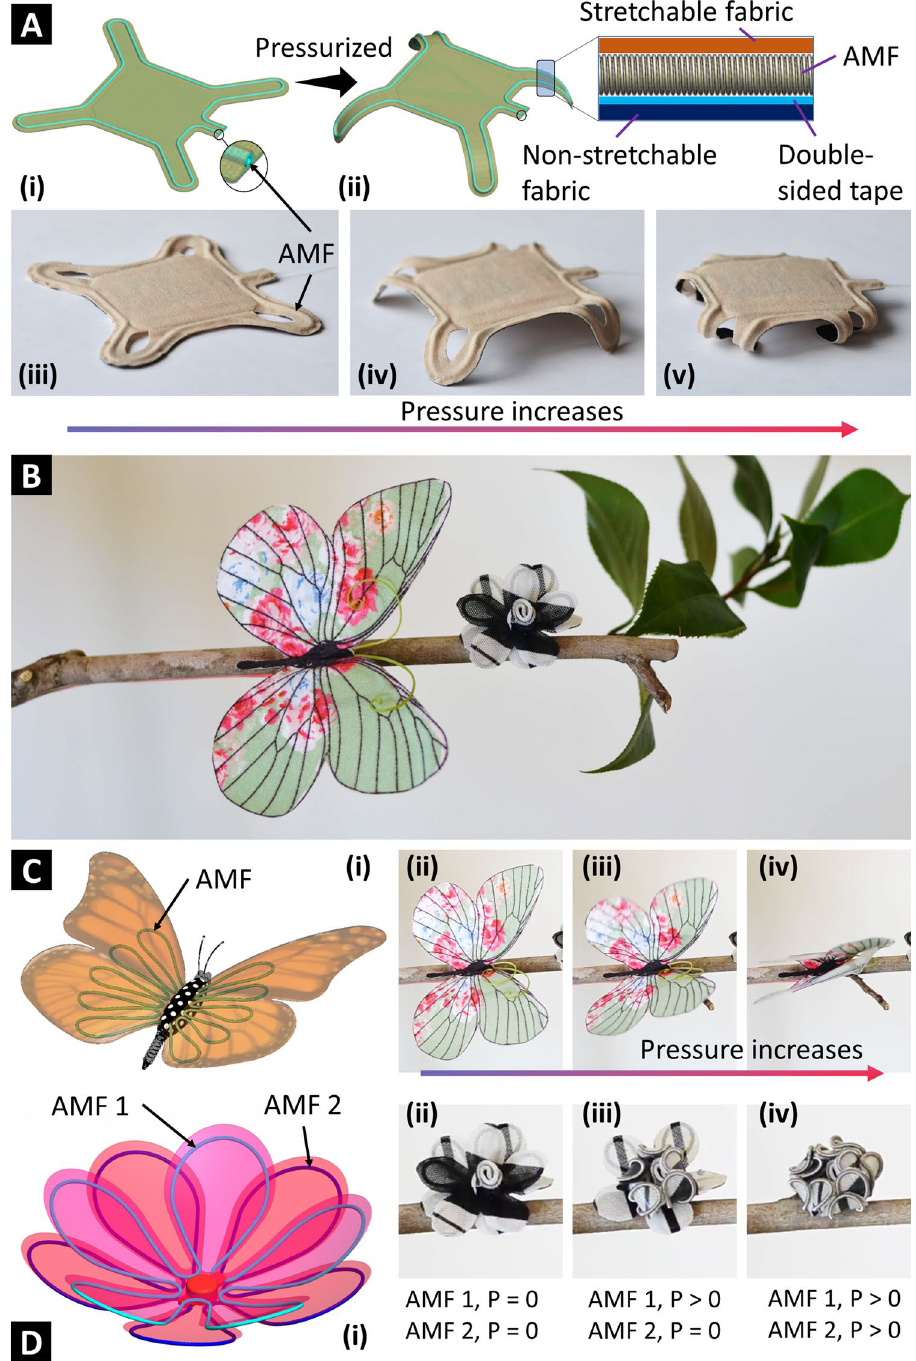
Figure 8. Fabric reconfiguration to produce shape-morphing structures. ( A ) Sticking an AMF to passive fabric sheet’s boundaries to turn it into a controllable four-legged structure. ( B – D ) Another two examples of fabric reconfiguration that turn the passive fabric butterfly and flower into active ones. Non-stretchable fabric: plain- woven cotton